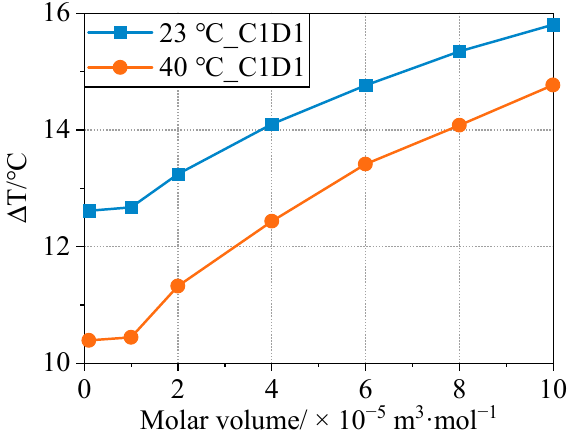
Figure 17. The maximum surface temperature rises during the discharging process of the cell after aging when using different SEI film molar volumes.